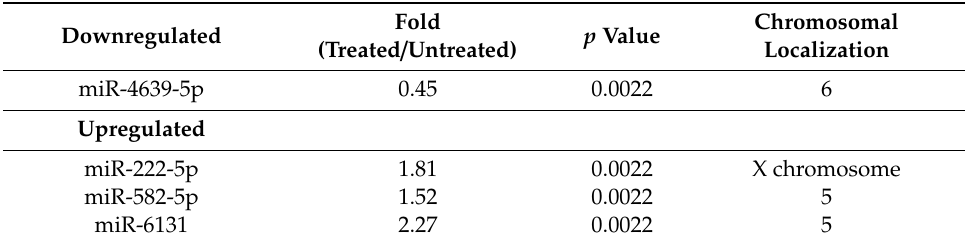
Table 1. Statistical results of miRNAs in KYSE-150 cells treated with or without Gal-9. Fold Downregulated p Value (Treated / Untreated)